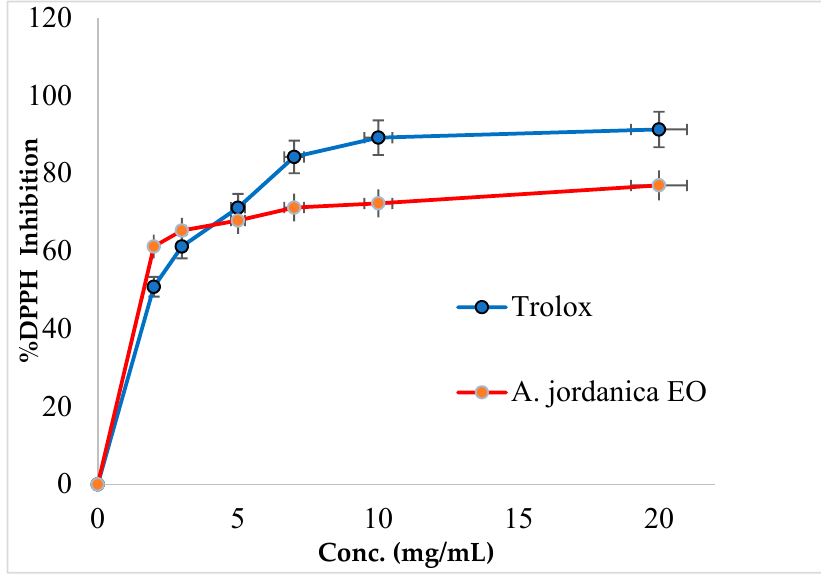
Figure 2. DPPH inhibitory activity by Artemisia jordanica essential oil and Trolox. Table 2. The IC 50 (µg/mL) for Artemisia jordanica essential oil against DPPH, lipase, α -amylase, α -glucosidase, and cancer cells in comparison with the positive controls.